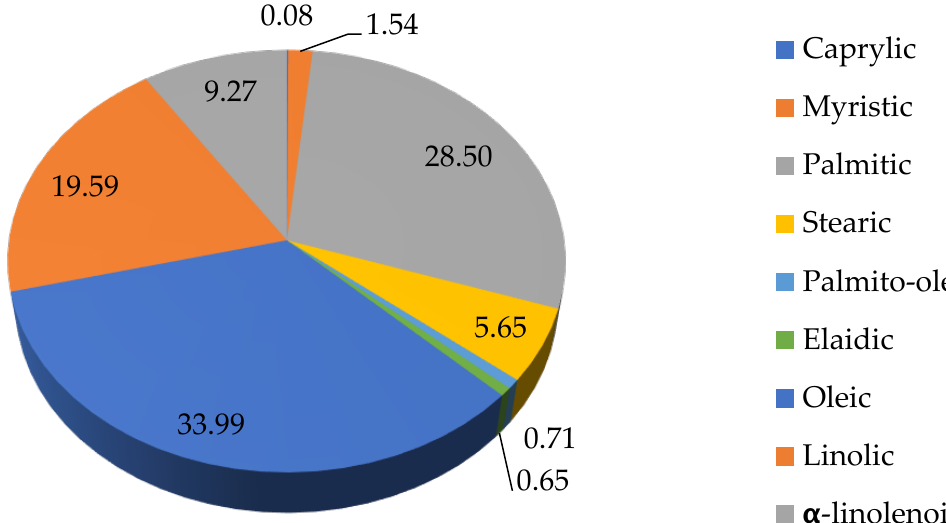
Figure 3. Percentage composition of various fatty acids in strain Rhodotorula kratochvilovae.